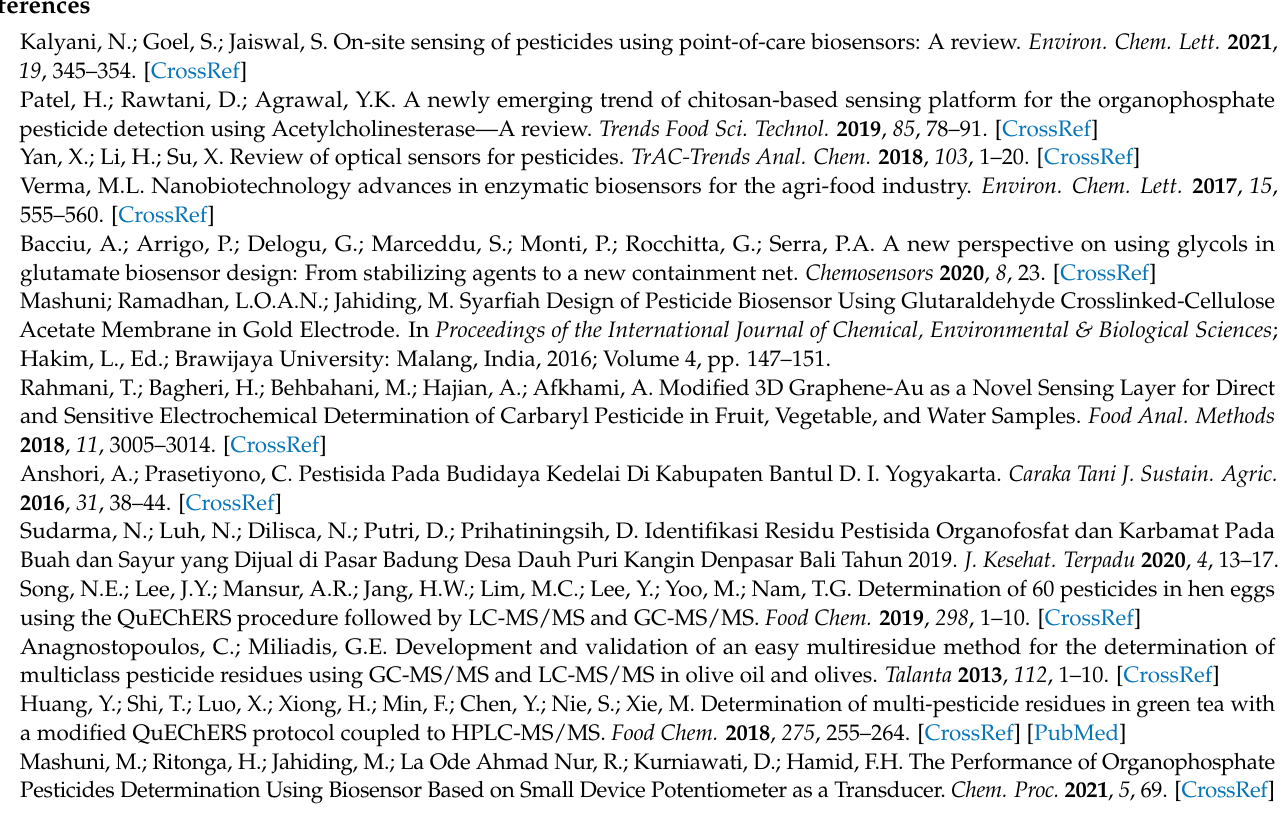
value, Table S2. Calculations for determination of Limit of Detection (LOD), Table S3. Calculations for determination of inhibition percentage, Table S4. Calculations for determination of measurements precision, Figure S1. Calibration curve of the relationship of –Log [Carbaryl] with the potential value (i) first, (ii) second, (iii) third, (iv) fourth, (v) fifth and (vi) mean of